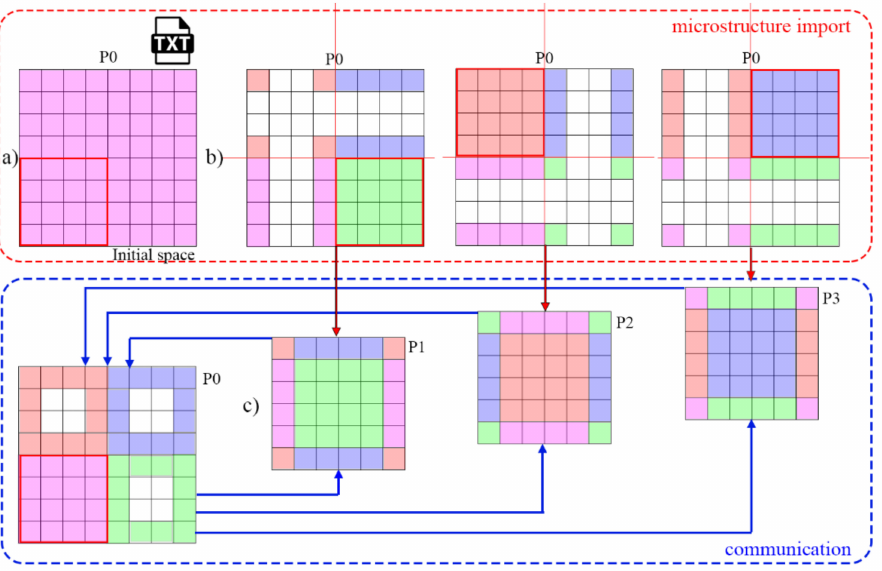
Figure 2. CA space preparation steps for the first parallelization scheme (mode 1). ( a ) The entire CA computational domain, ( b ) initial microstructure data loaded to the P0 process, and ( c ) information exchange within the P0 and remaining MPI processes.